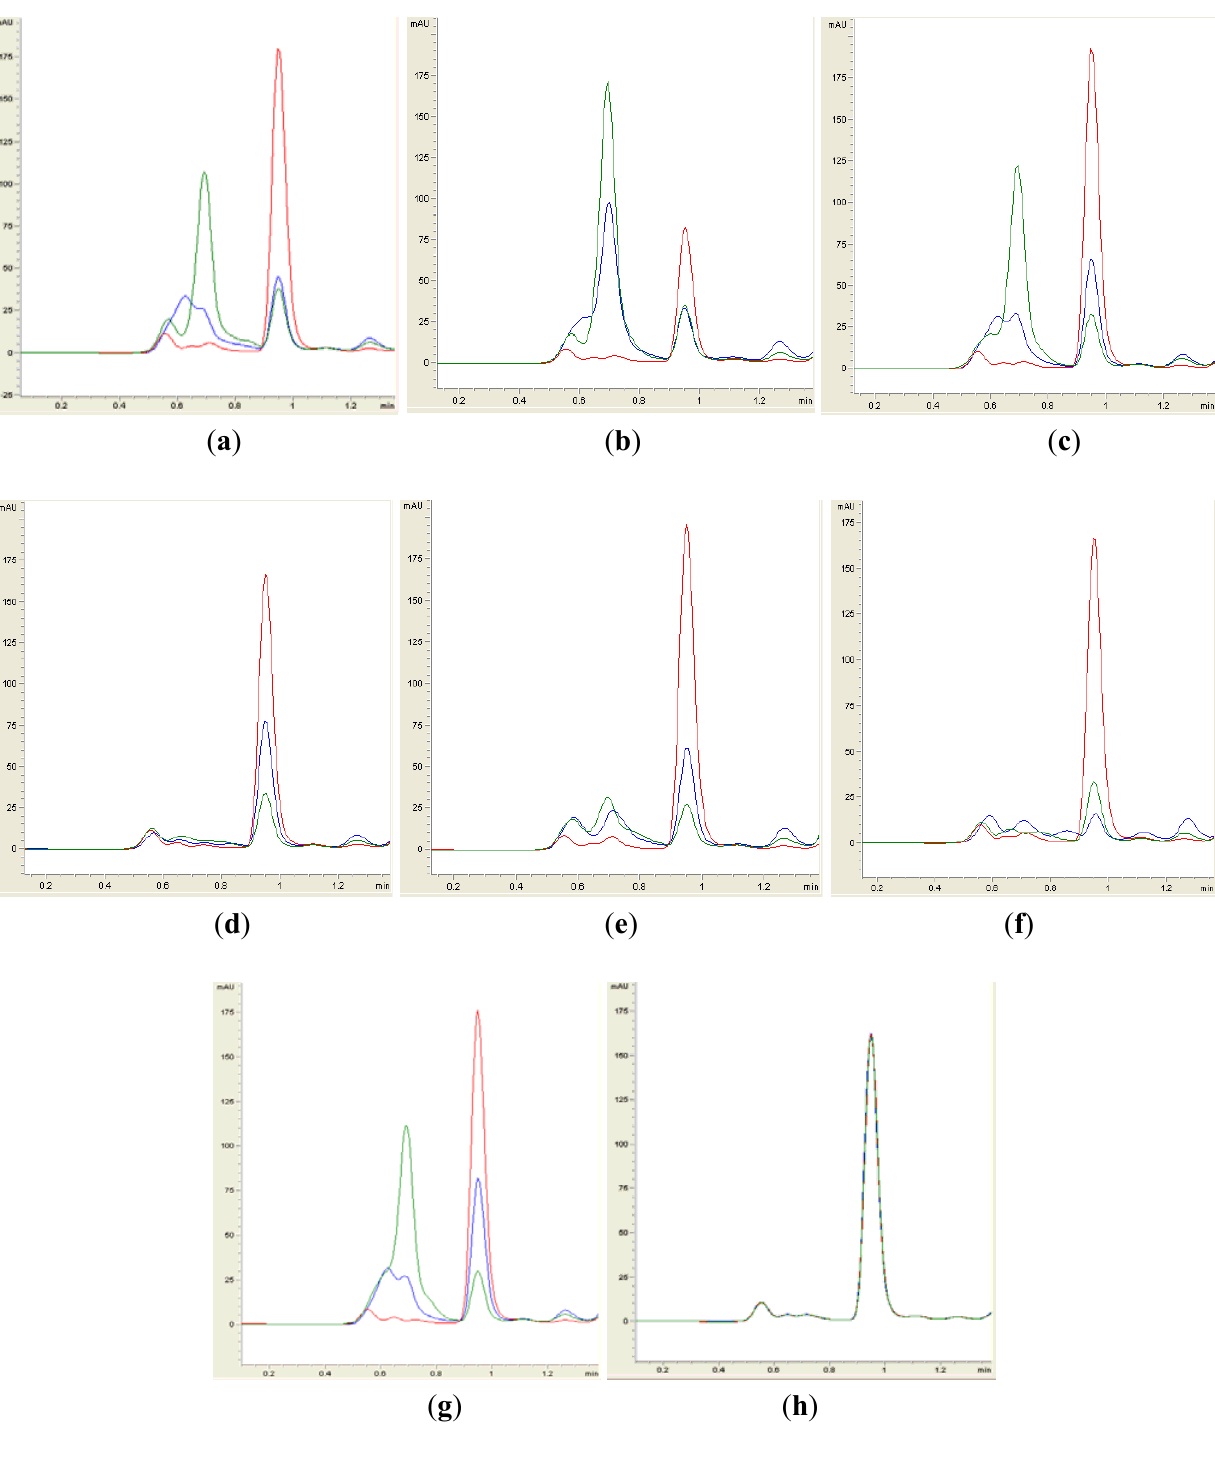
Figure 3. RRLC analysis of 3-oxo-C12-HSL degradation. Residual 3-oxo-C12-HSL (with elution time of 0.95 ± 0.02 min), after degradation for 0 h (red), 3 h (blue) and 24 h (green), was monitored and degradation of 3-oxo-C12-HSL was observed for all bacteria tested, such as BT1 ( a ), BT2 ( b ), BT4 ( c ), BT6 ( d ), BT8 ( e ), BT9 ( f ) and B. cereus ( g ). PBS solution ( h ) was the negative control for the